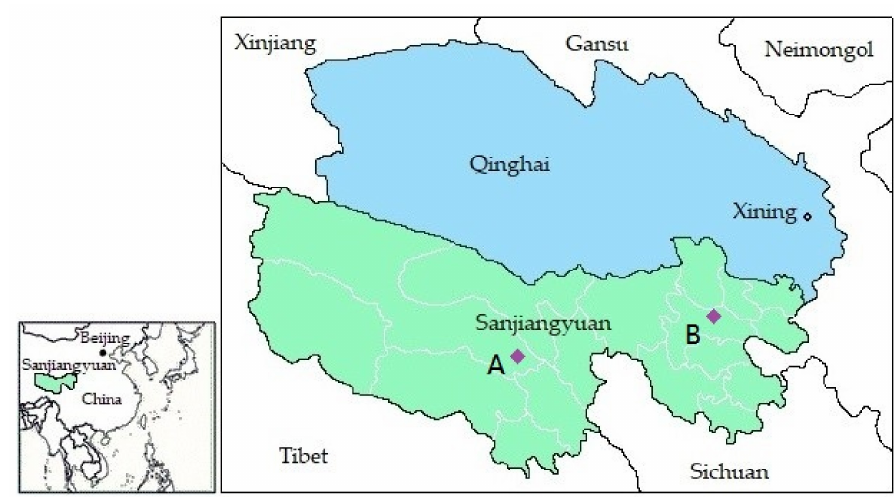
Figure 2. Sanjiangyuan National Nature Reserve is located in the southern part of Qinghai Province, China. Two purple diamond marks A and B represents the location of the current proposed dataset: the mark A in the middle of Sanjiangyuan is located in Yushu County, Qinghai Province; The mark B in the eastern part of Sanjiangyuan is located in Guoluo County, Qinghai Province.